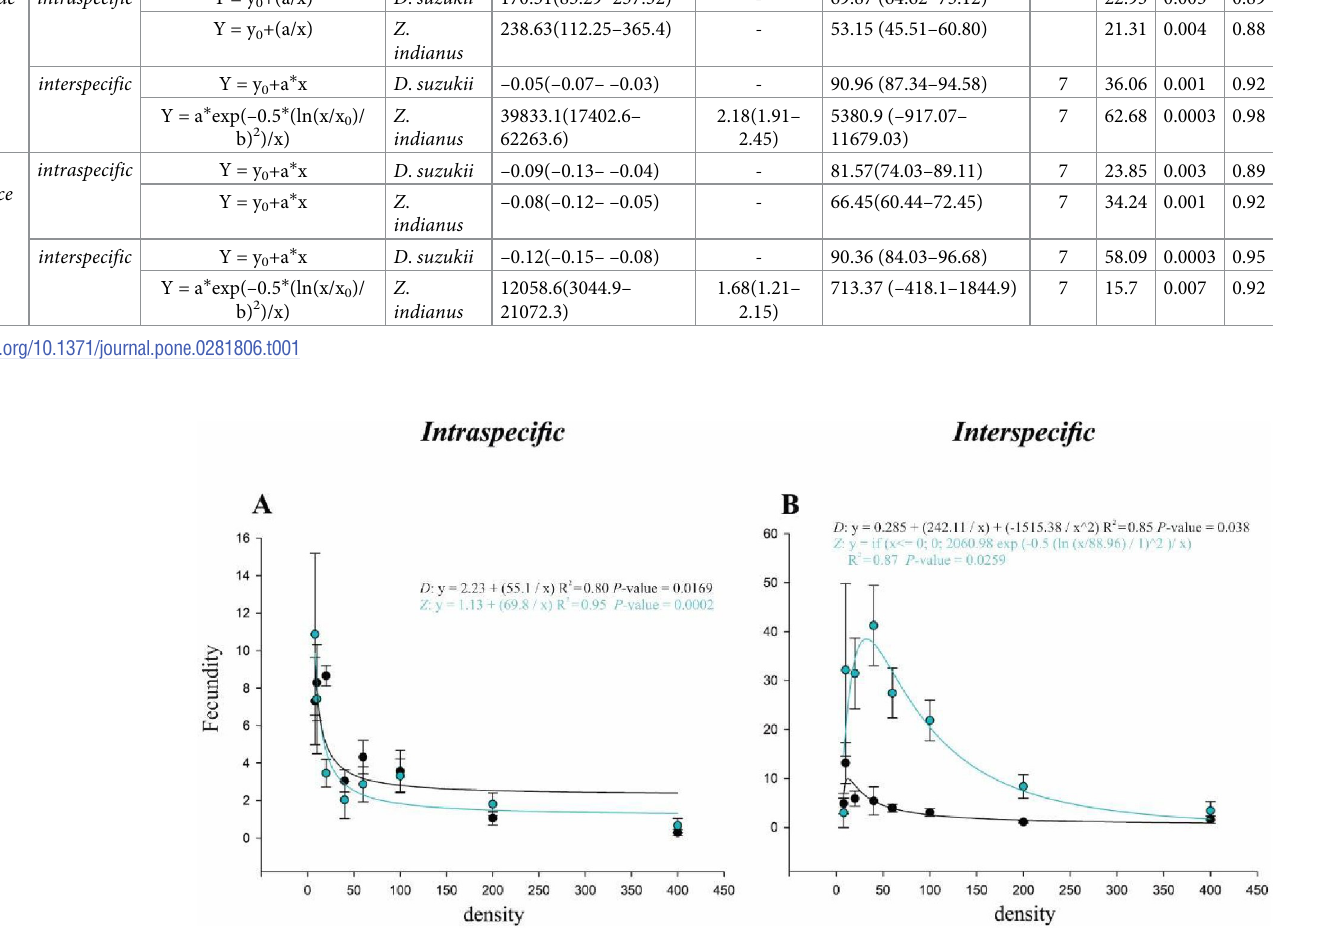
Fig 3. Fecundity bioassay. Fecundity response of Drosophila suzukii (D) and Zaprionus indianus (Z) fitted to regression functions to eight intra- and interspecific egg densities, i.e., 8 to 400 eggs. (A) Intraspecific mean fecundity per female. (B) Interspecific mean fecundity per female. Black points and curves represent D . suzukii ; green points and curves represent Z . indianus . https://doi.org/10.1371/journal.pone.0281806.g003 Table 2. Summary of regression analyses for fecundity of Drosophila suzukii and Zaprionus indianus (shown in Fig